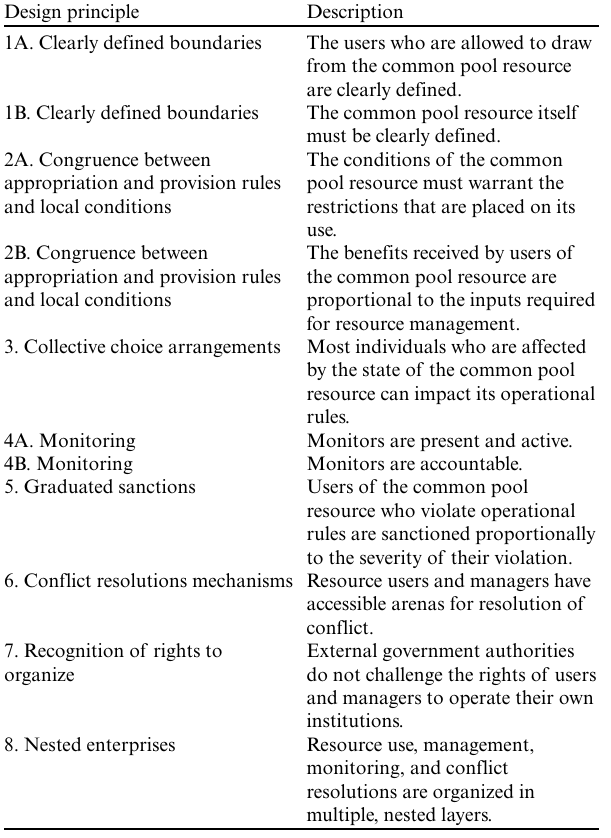
Table 1 . Design principles and their definition, as described by Cox et al.